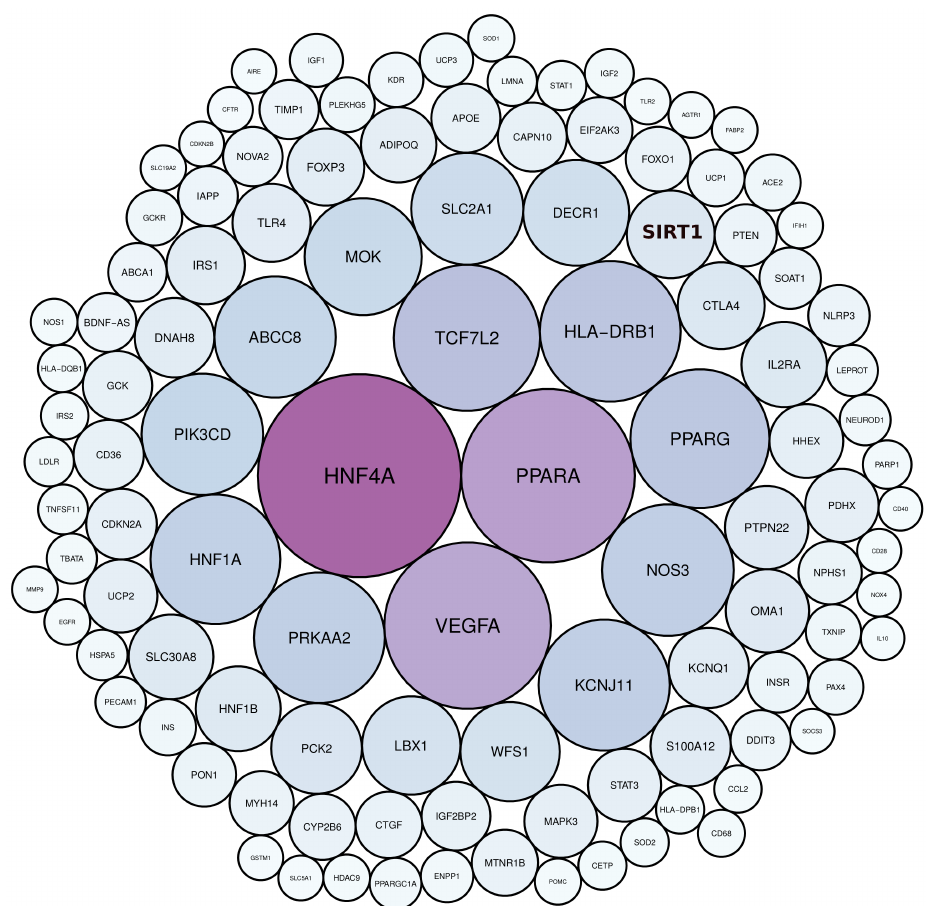
Figure 2. The most frequently mentioned genes in diabetes literature, as determined by text mining. The colour and size of the circles are proportional to the frequency of gene terms in diabetes literature.